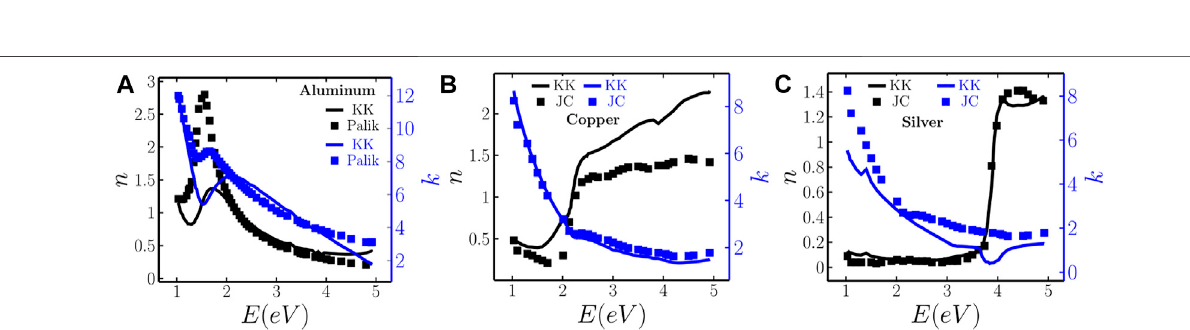
FIGURE 2 | Variation of real and imaginary parts of dielectric constants for aluminum [ (A , D) ], copper [ (B , E) ], and silver [ (C , F) ], respectively, with energy of incident lightas well as varying fl uence of Argon ions. Black solid line represents the data obtained from KK technique and colored (red, blue, and green) solid lines represent the data obtained from MG approximation.